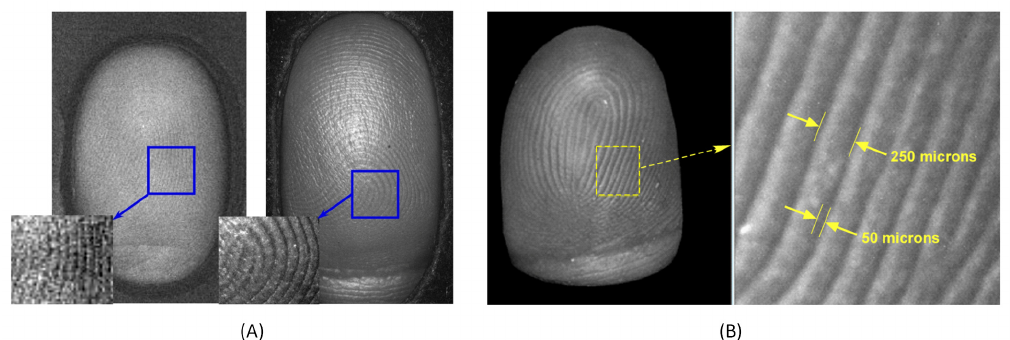
Figure 5. (a) Image comparison of infant finger taken at 1500 ppi (left) and 3400 ppi (right) and (b) variations in ridge and valley